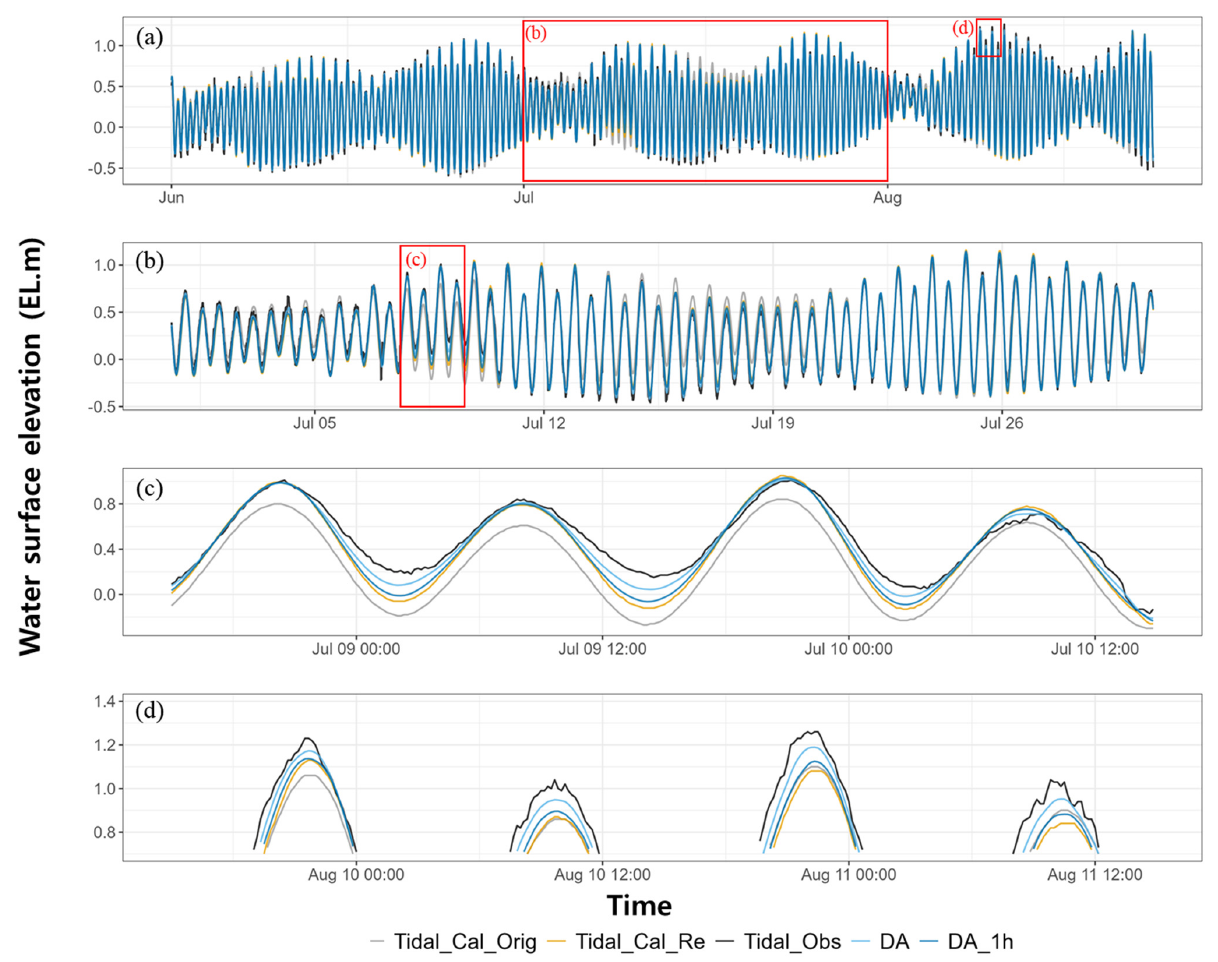
Figure 5. Predicted water surface elevation was measured via multiple methods and compared to the observations: ( a ) time series of the observed and predicted surface water elevations for the full simulation period, ( b ) time series of the observed and predicted surface water elevations for a month, ( c ) time series of the observed and predicted surface water elevations for two days, ( d ) peak of the observed and predicted surface water elevation time series for two days.